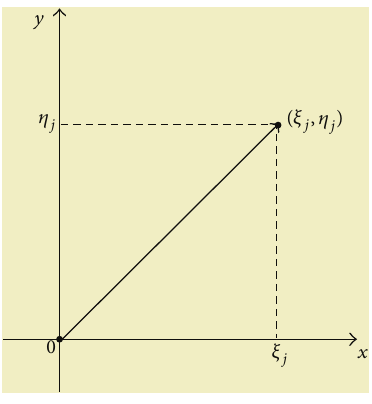
Figure 1: Shift of a singular point.